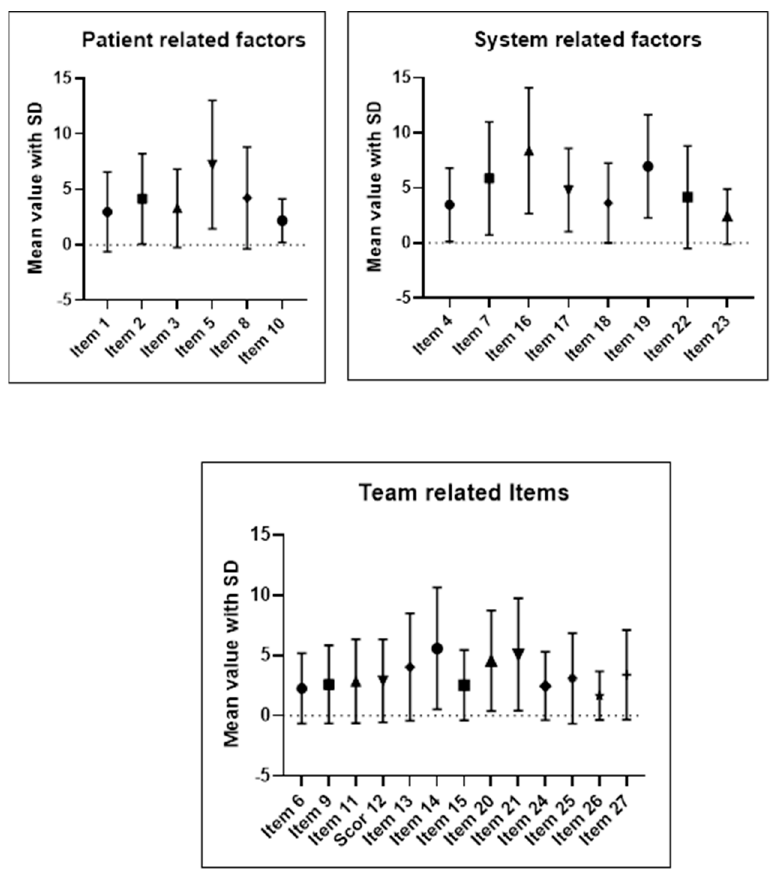
Figure 1. Individual analysis of each item of the MMD-HP score, as grouped in patient-related, team-related, and system-related factors. Results are displayed graphically using means and standard deviation.